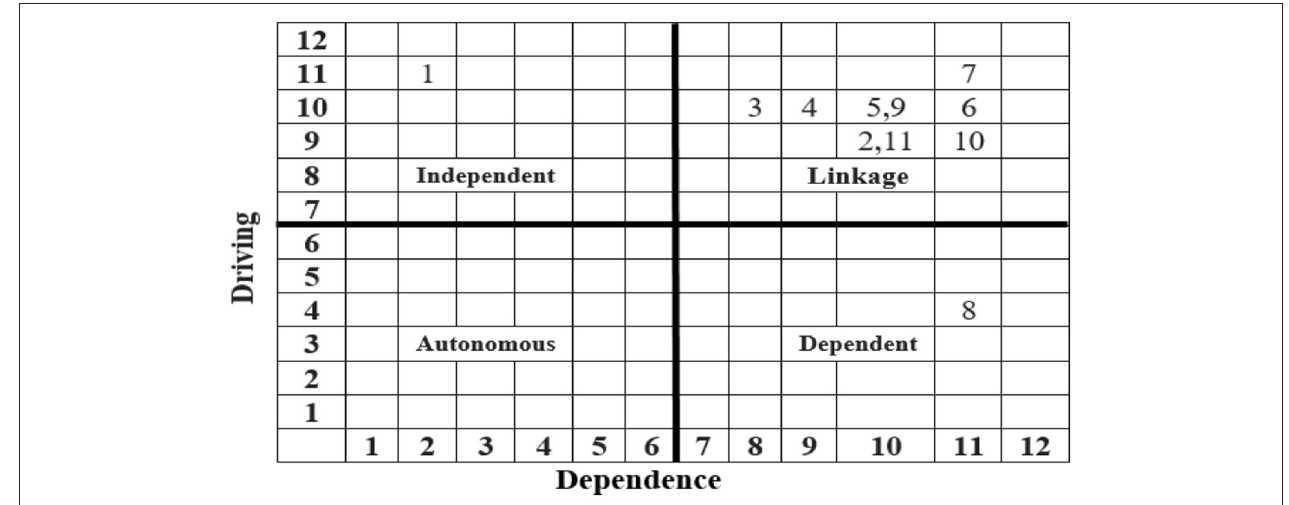
FIGURE 2 | Driving-dependence diagram.